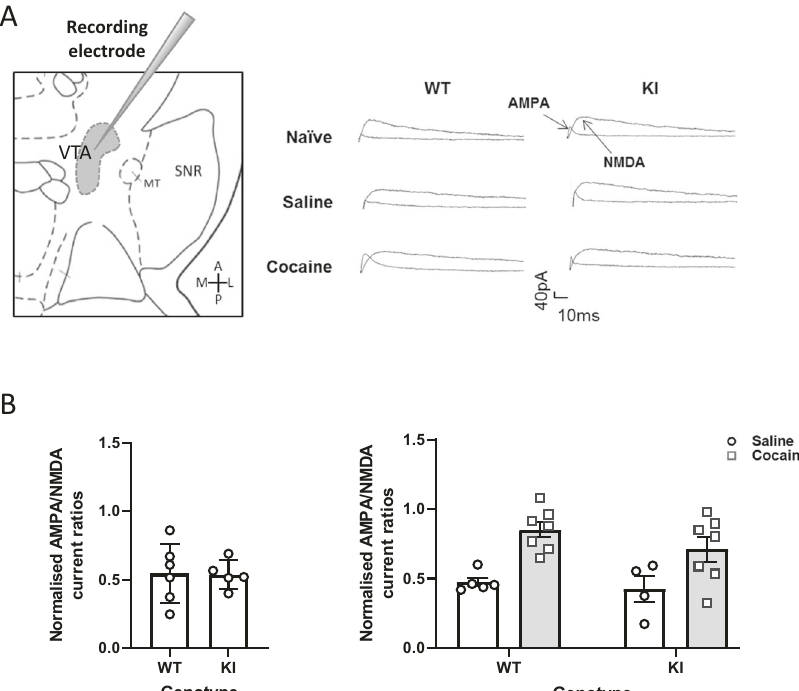
Fig. 1 Acute cocaine exposure increases AMPA/NMDA receptor current ratio in the VTA in WT and KI mice. A Sample EPSCs were recorded from dopamine neurons in WT and KI naïve mice or WT/KI mice pretreated with cocaine or saline, in the Ventral Tegmental Area (VTA). B Peak AMPAR- and NMDAR-mediated EPSCs current ratio from naïve WT and KI mice ( N = 4 – 7) expressed as a ratio in the VTA. Left : Data were analysed by unpaired t -test ( t = 0.0773), Right : Data were analysed by two-way ANOVA. Data expressed as mean ±